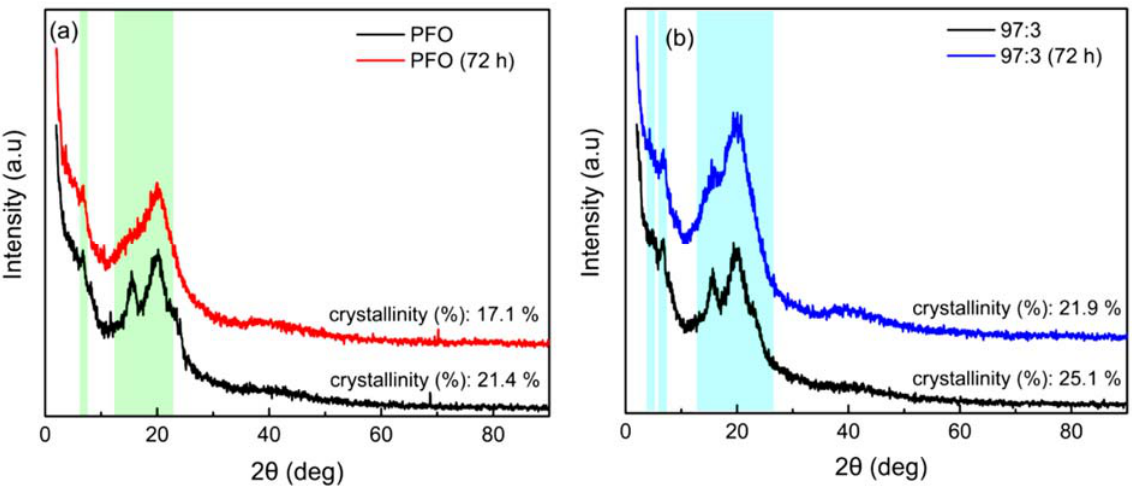
Figure 6. XRD analysis of ( a ) pristine PFO films and ( b ) 97:3 aggregated PFO films before and after thermal degradation test.